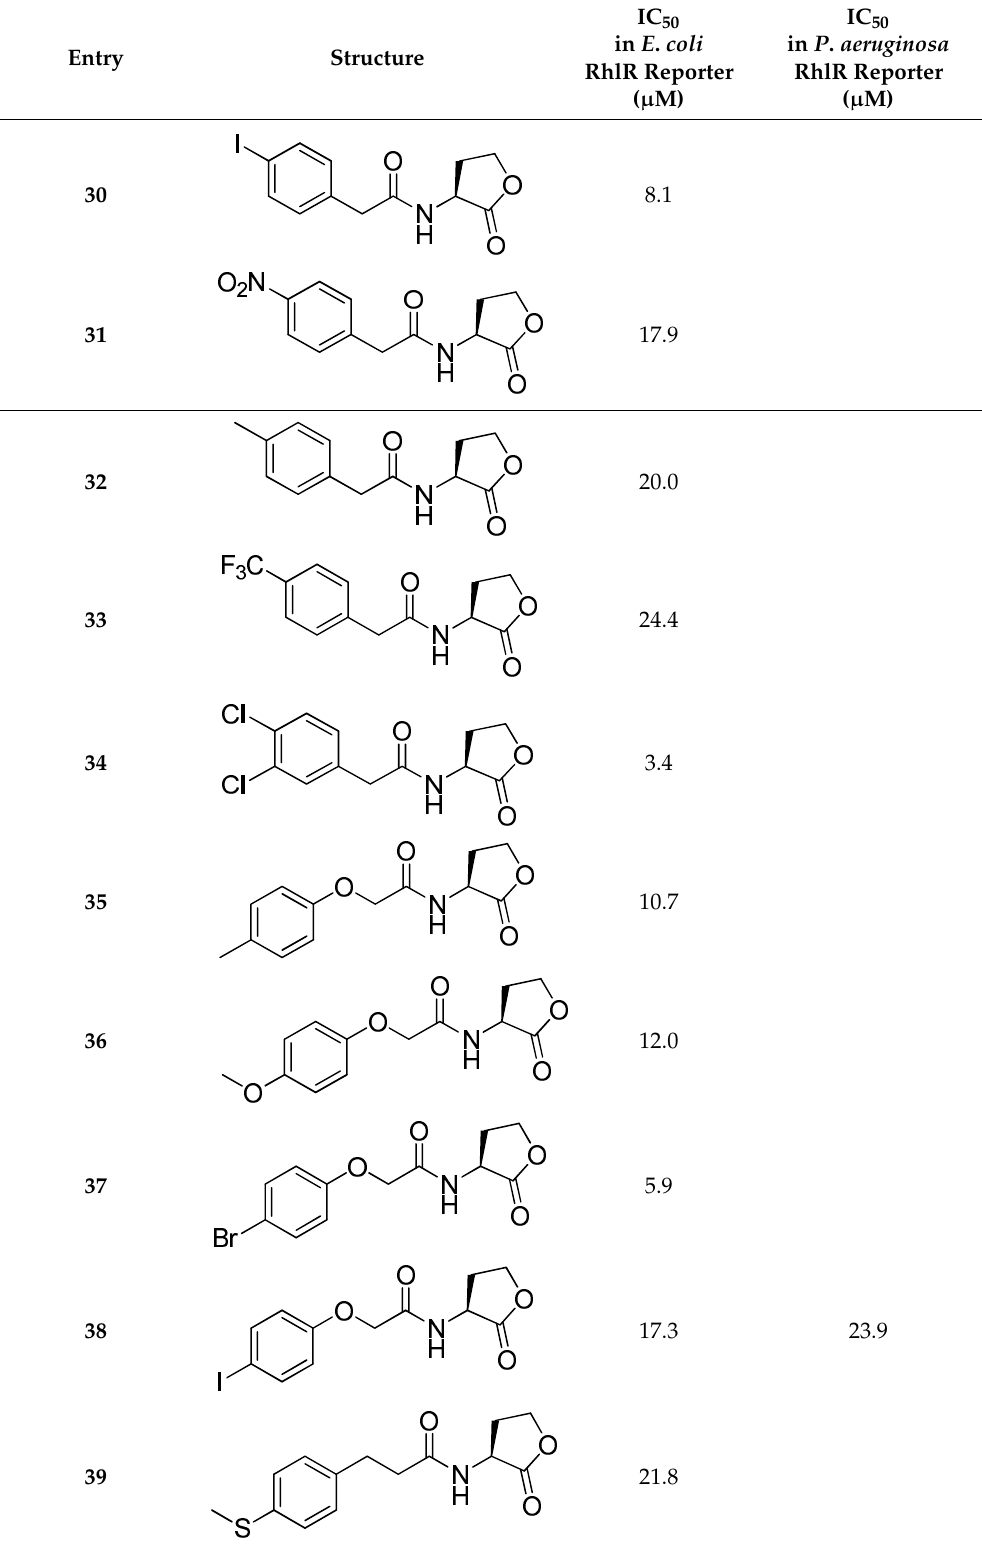
Table 4. Phenylacetyl or phenoxyacetyl analogs as RhlR antagonists.